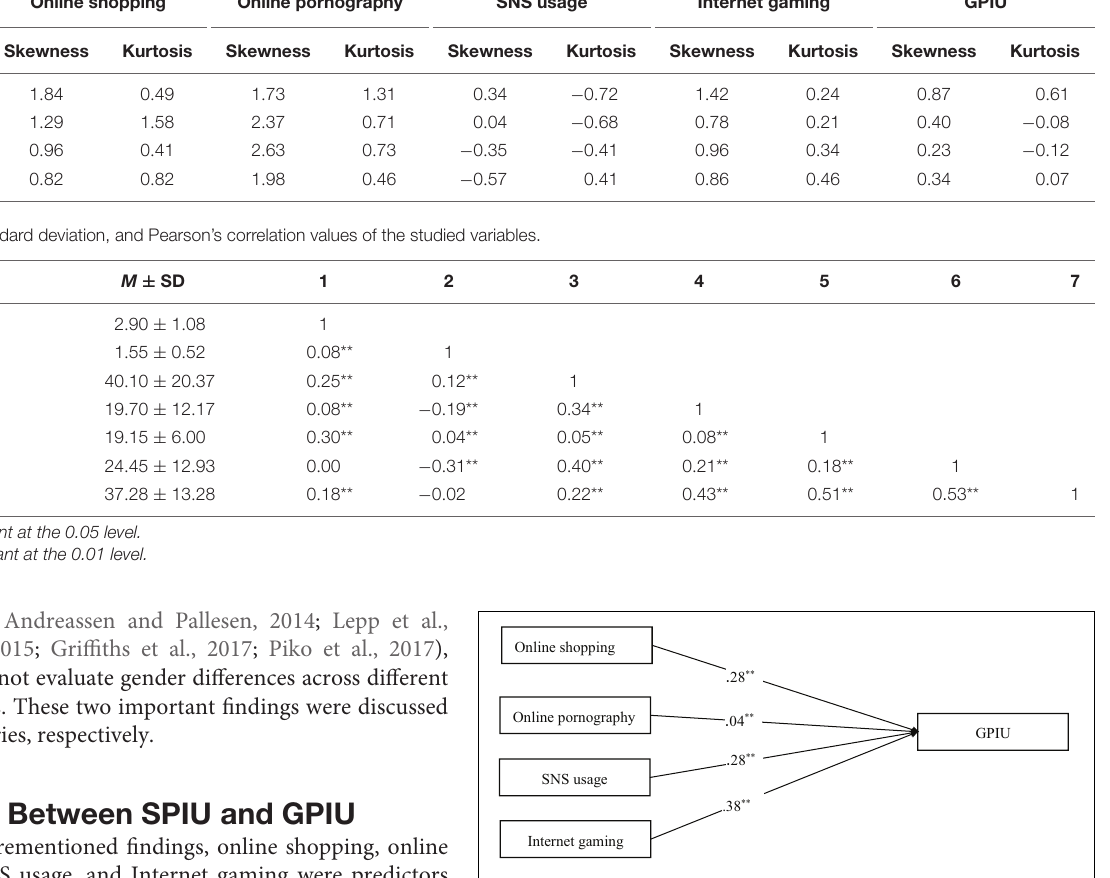
TABLE 1 | Skewness and kurtosis values for each variable. Items